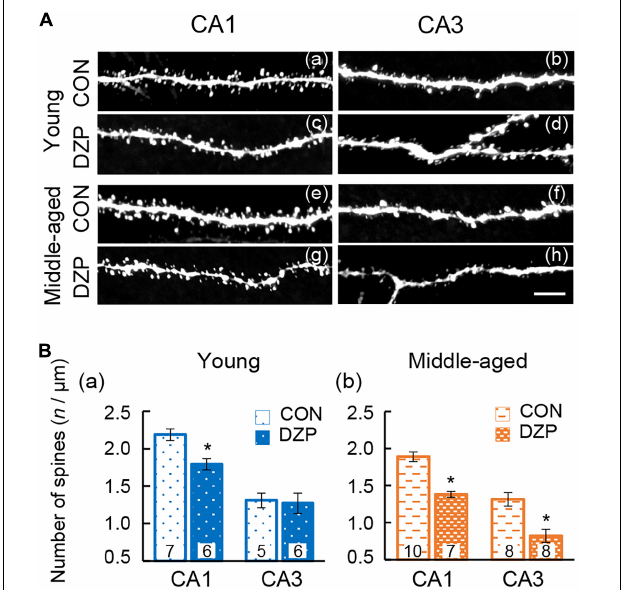
FIGURE 4 | Effects of chronic diazepam administration on the spine density of hippocampal neurons. (A) Representative images of visualized spines in the CA1 and CA3 regions of young and middle-aged mice. (B) Spines were counted and the results are summarized in bar graphs. The number in bar graph indicate the number of analyzed neurons ( N = 4 animals, 1–3 neurons/animal). Scale bar, 5 µ m. Error bar: mean ± SEM. * P < 0.01, t -test, vs. CON. CON, control group; DZP, diazepam group.